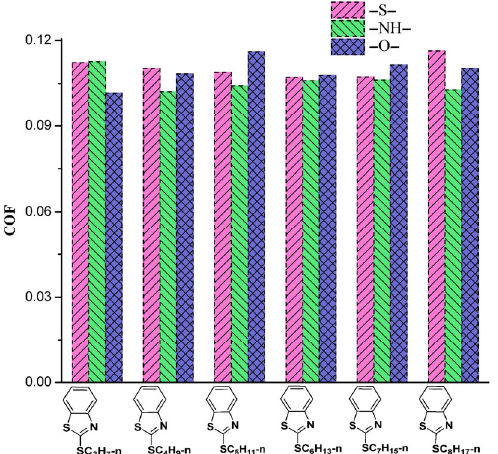
Fig. 18 The friction coefficient when lubricating with thioben- zothiazole compounds and their isosteres in triisodecyl trimellitate.